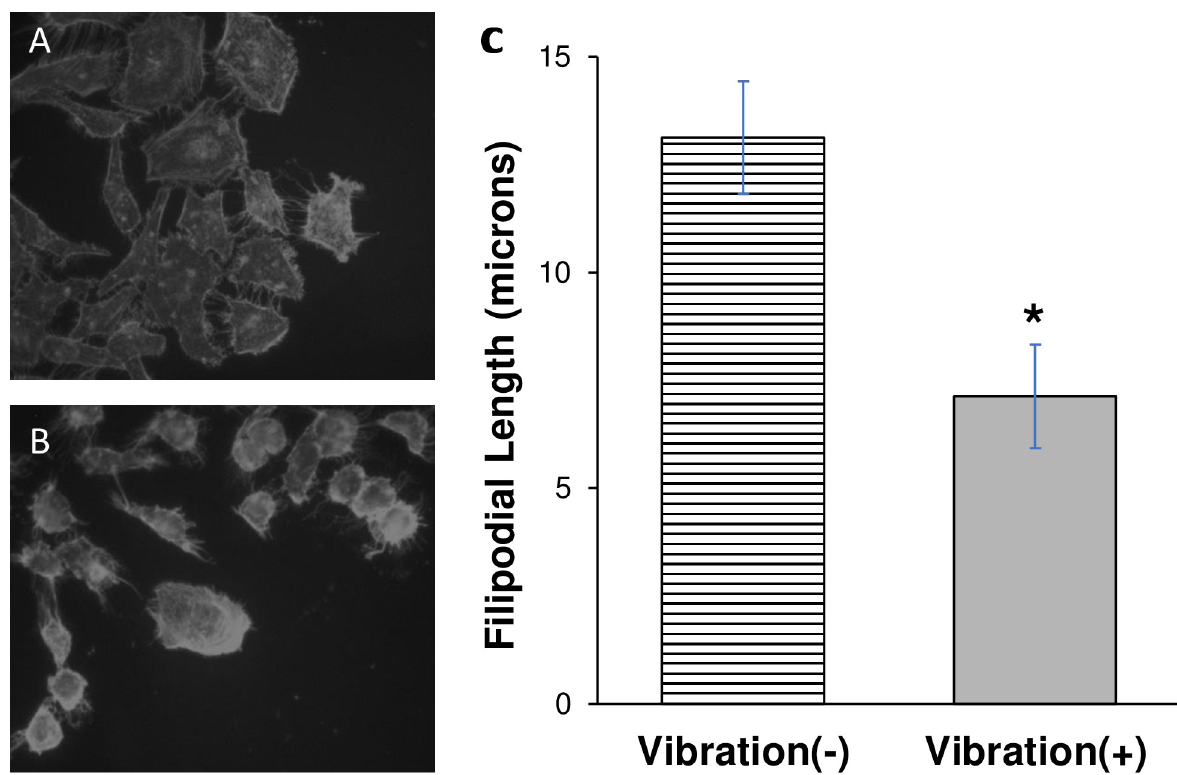
Fig 2. Vibration alters actin filament organization. Representative fluorescence micrographs of HeLa cells without vibration (A) and with vibration (B) stained for actin filaments. Filopodial length calculated using ImageJ image analysis software. Field of view diameter for 400x total magnification set to 450 microns. Individual filopodia ( � 100, with maximum of five per cell) were marked from cell body to end for length measurement. Stress fibers running across entire cell body were excluded. Data shown as average filopodial length in microns ( ± sem for three independent experiments) (C). � = p < 0.05 Vibration (+) [solid bar] vs. Vibration (-) [striped bar].